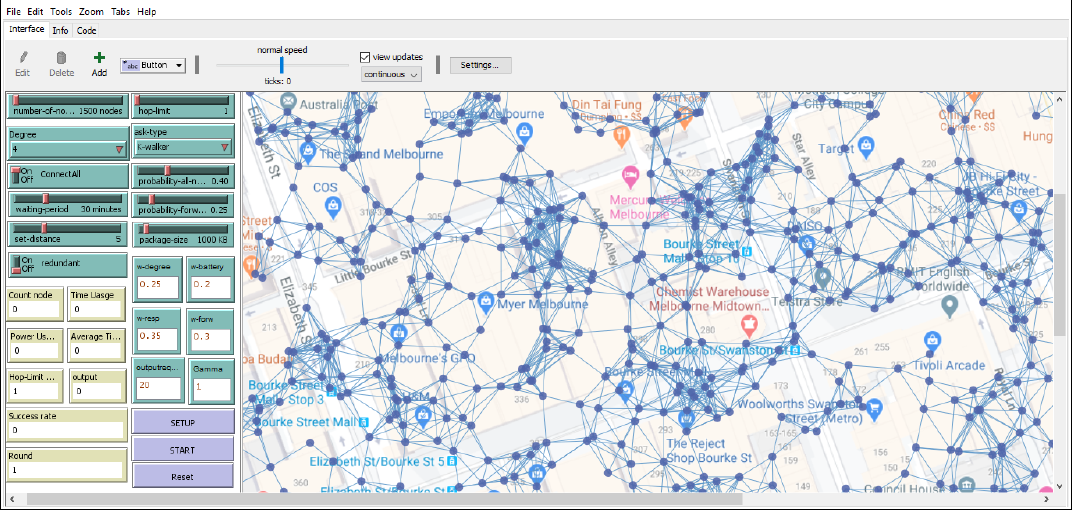
Figure 3. Simulation interface for the testbed peer-to-peer (P2P) spatial crowdsourcing network—note the geographical spread of the network in the background map.